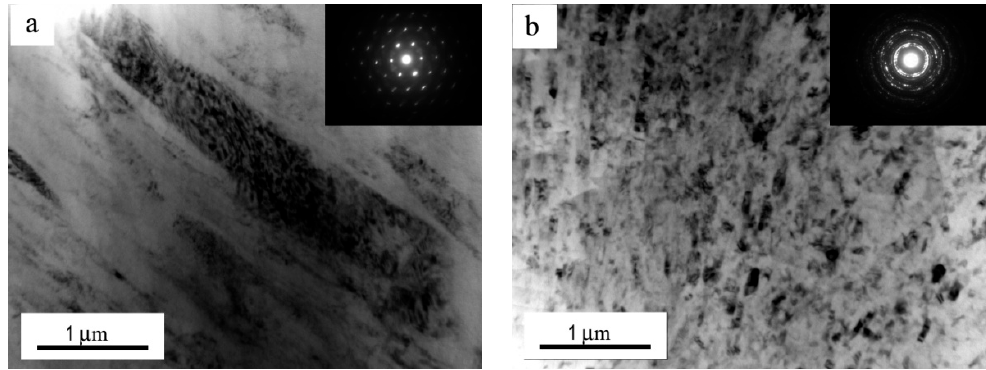
Figure 8. TEM images at 25 μ m deep from the top surface for the Mg97Zn1Y2 pins worn under 0.8 m/s: ( a ) 70 N, ( b ) 140 N.